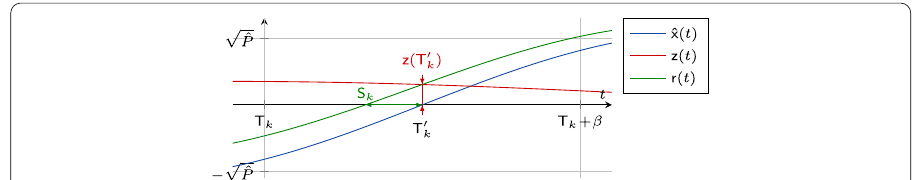
Fig. 5 Transformation from amplitude noise z ( T ′ k ) to shift error S k for an SNR of 10 dB. In the transition β T k , T k interval , the transmitted signal is represented by the filtered transmit waveform ˆ f ( t [ + ]